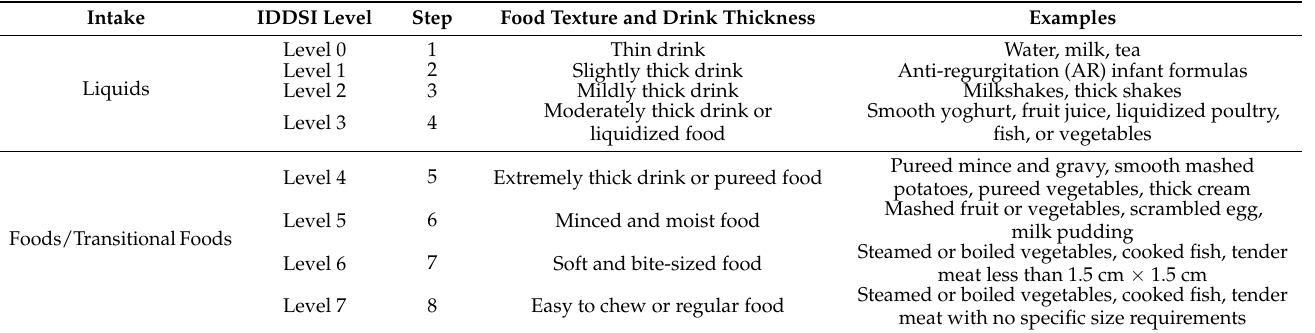
Table 1. Bolus intake for wet swallowing in the pre-test phase.